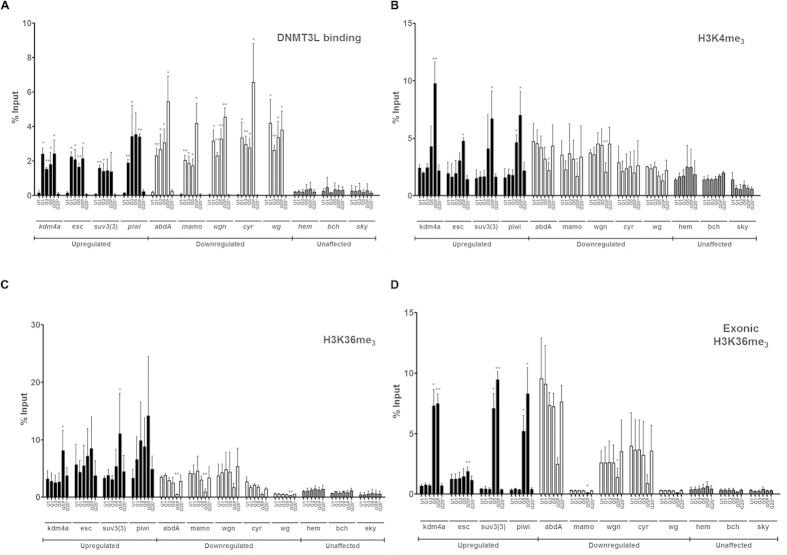
ChIP analysis for association of DNMT3L and specific Histone modifcations with specific gene promoters.Graphical representation of the DNMT3L binding (A), association of H3K4me3 (B) and H3K36me3 (C) with the promoter and HeK36me3 within the exonic regions (D) of selected upregulated, downregulated and unaffected genes tested by ChIP using specific antibodies. Results are represented as % input. The names of the specific gene promoters tested are given below the X-axis. U1- control larvae without GAL4 driver from the 1st generation G1, G3 and G5- Tub-3L larvae from the indicated generation. G5P denotes 5th generation Tub-3L larvae having melanotic tumors. G20* denotes larvae from G20 generation after crossing out of the Tubulin-GAL4 driver. The error bars represent Standard Deviation (S.D.). *Indicate significant difference (Student’s t test, *p < 0.05, **p < 0.01).